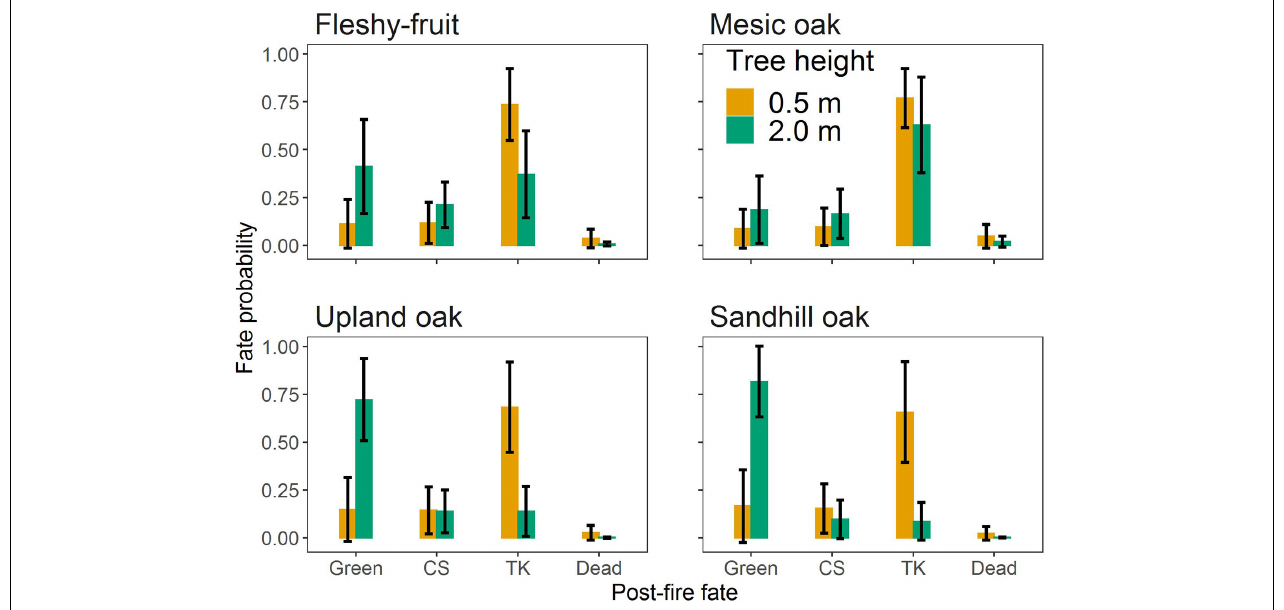
FIGURE 3 | Predicted probability (narrow bars indicate 95% confidence limits) of post-prescribed-fire fate of shrub-form hardwood trees 0.5 and 2.0 m in height in longleaf pine woodlands in southwest Georgia, United States. Probabilities were calculated based on a low FRED (0.35 MJ m − 2 ). See Figure 2 for fate